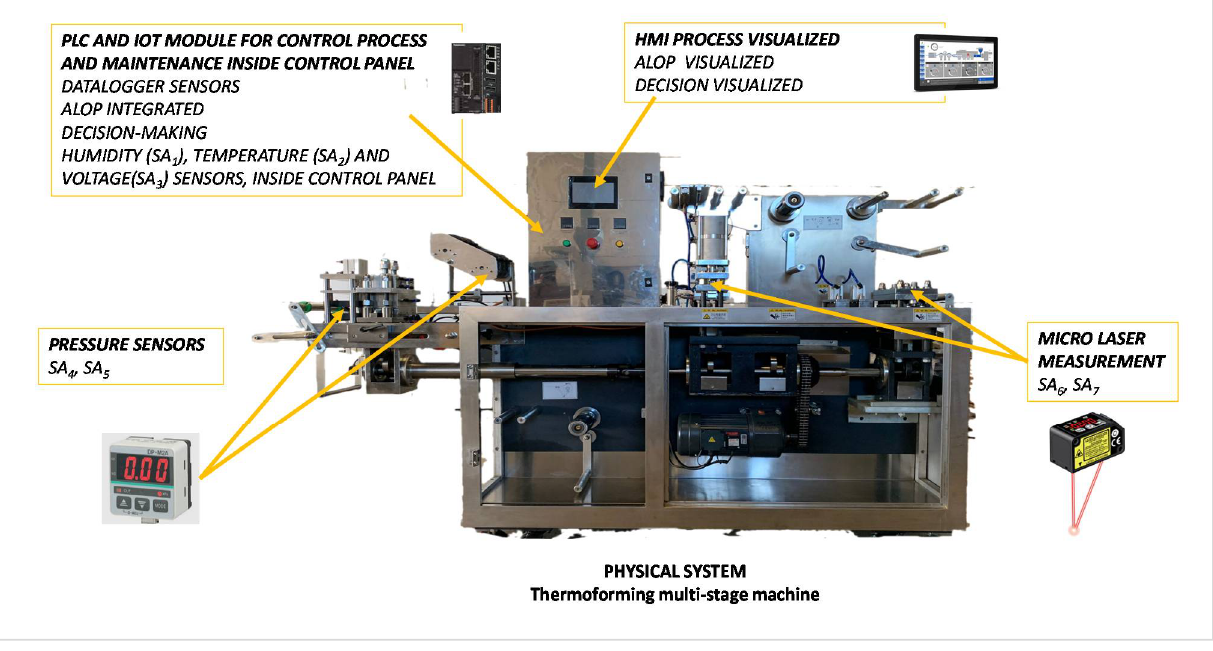
Table 4. Sensors and components used for the ALOP model.